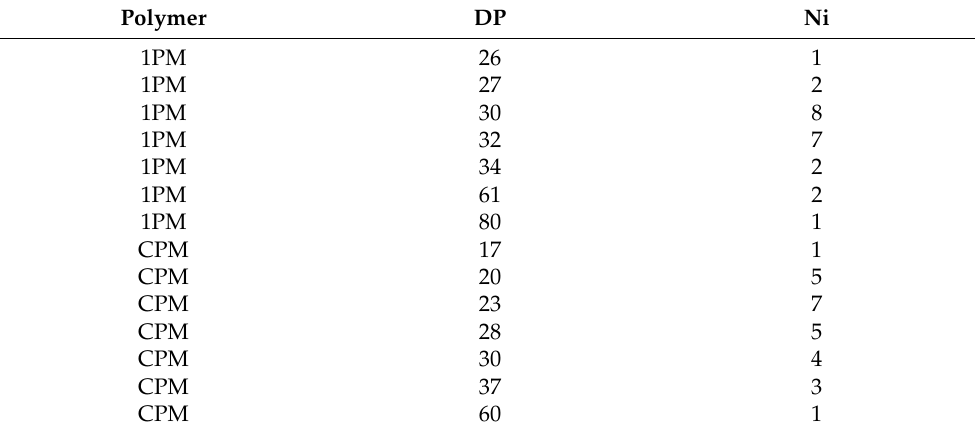
Table 2. Polymerization degree and corresponding number of